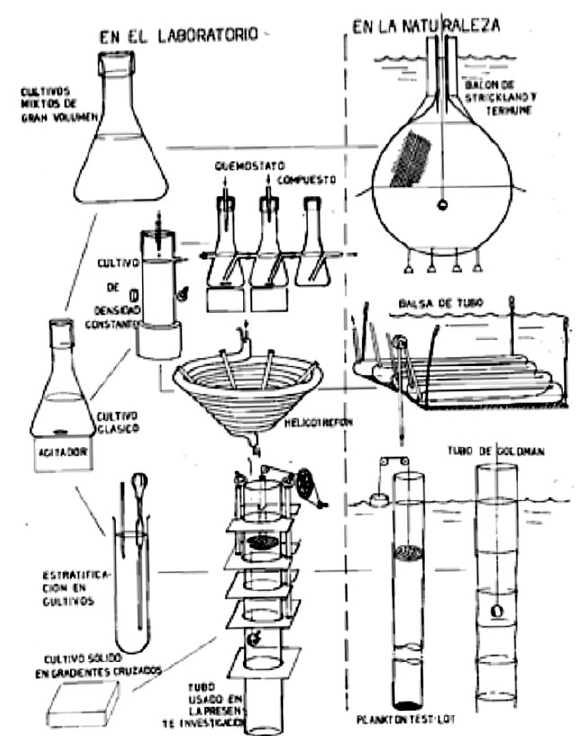
Fig. 14. – Laboratory and field devices used and discussed by Ra- mon Margalef as physical models of marine ecosystems. (Margalef